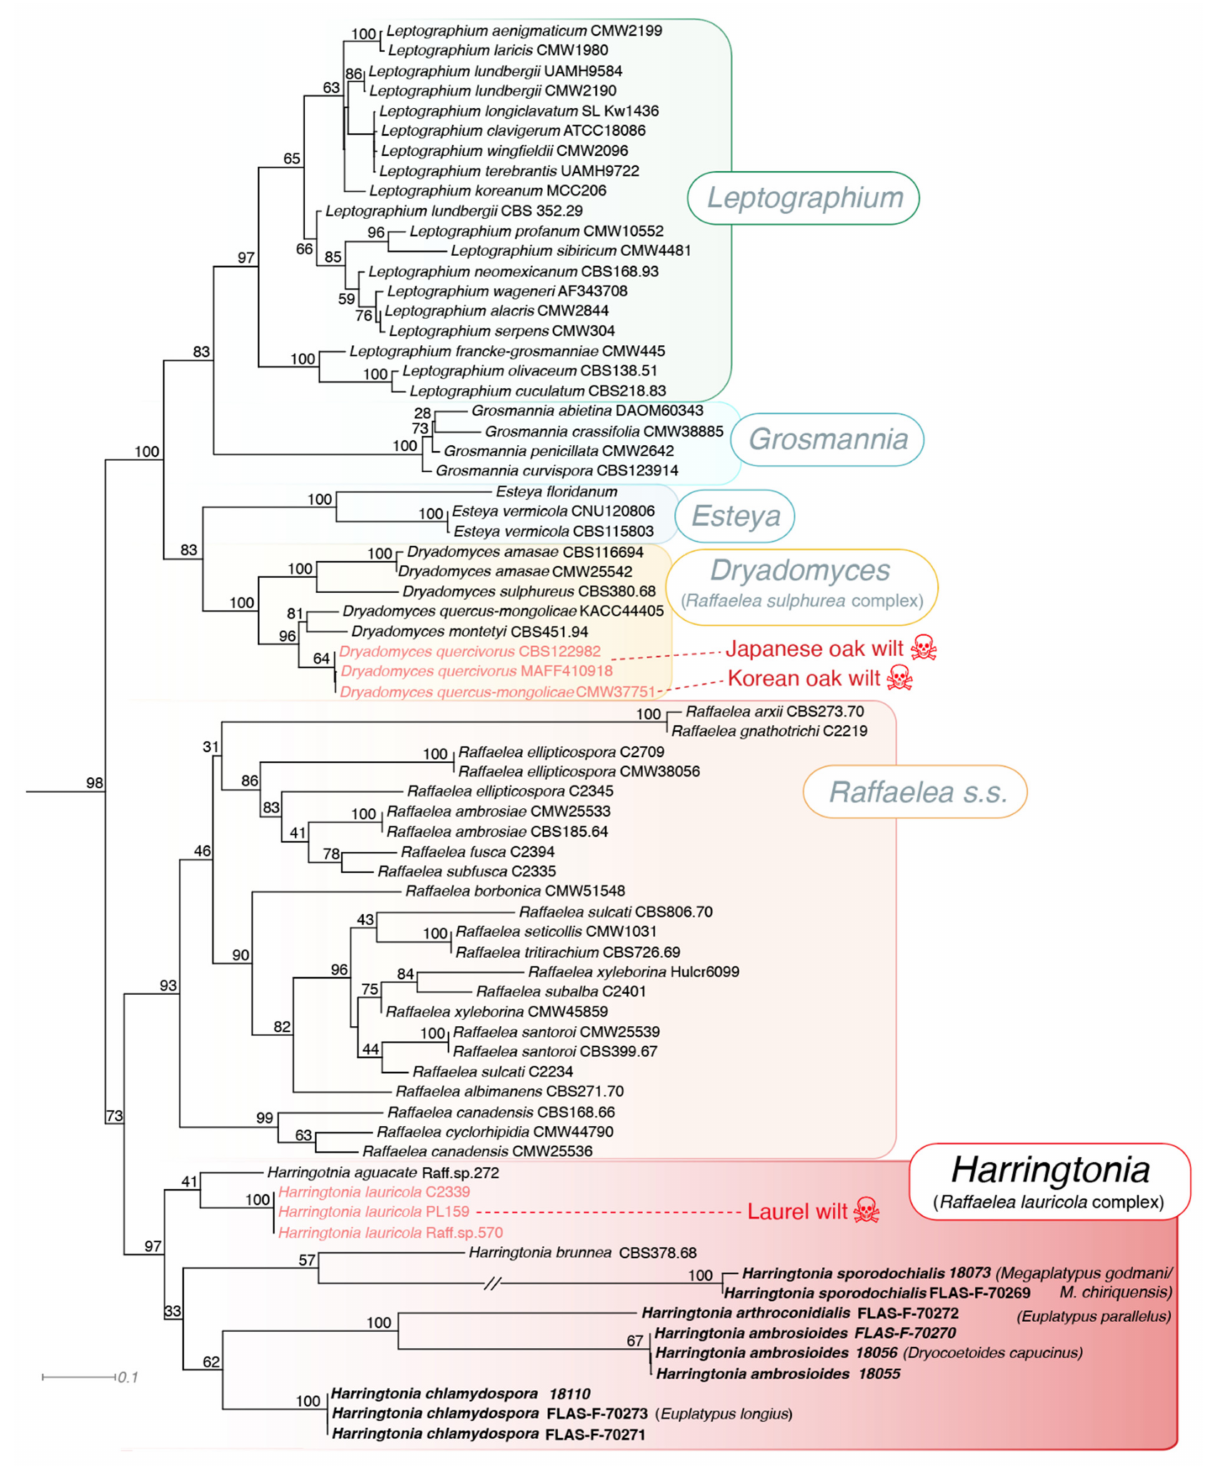
Figure 1. Maximum likelihood tree obtained from RAxML analysis of the concatenated dataset composed by LSU, ITS and ß-Tubulin of ophiostomatalean species. Our dataset was composed of 73 isolates and final concatenated alignment consisting of 3253 bp. All bootstrap values are shown. The new species of Harringtonia proposed are in bold. Numbers near genus and species epithets refer to isolate numbers and vector beetle species are indicated to the right of the four new species of Harringtonia . Note: Megaplatypus godmani / chiriquensis refers to an ambiguous beetle ID, not two different beetle species being associated with H. sporodochialis